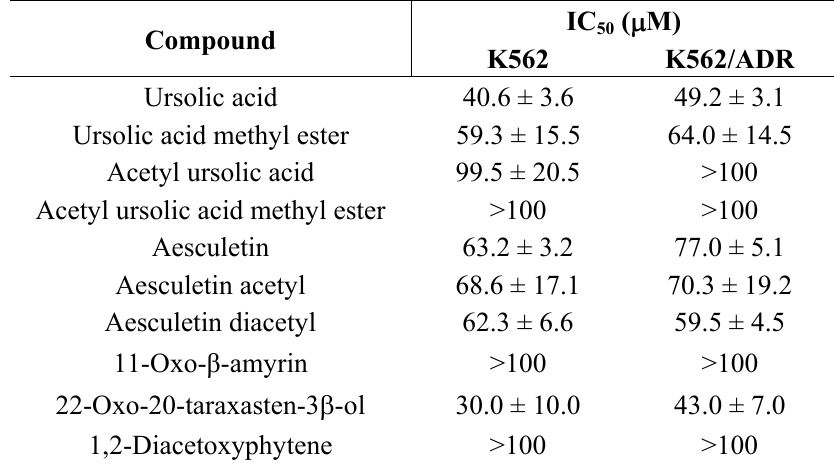
Table 5. Effects of some compounds and derivatives isolated from T. proustii and T. lagopoda on the growth of the human leukemia cell